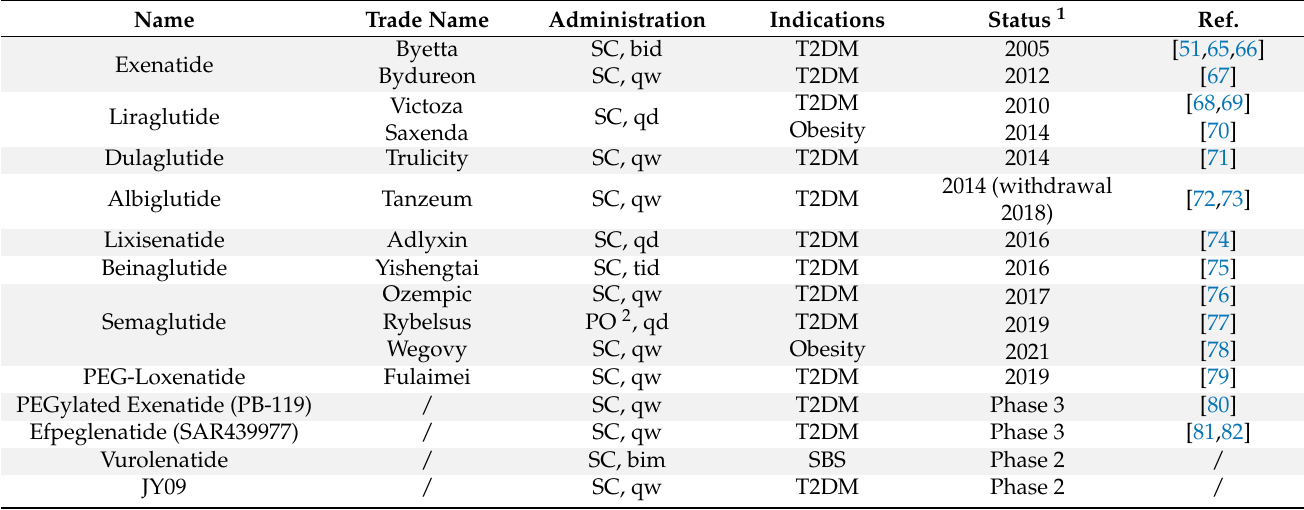
Table 1. Peptide-based mono-agonists targeting